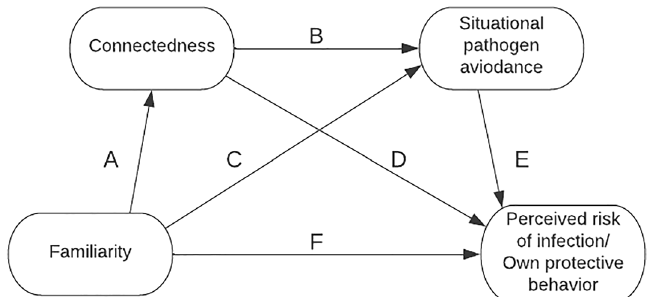
Figure 1. Multiple mediation model predicting perceived risk of infection and protective behaviours. Note: Data from the present studies show that greater familiarity was related to greater connectedness, which was associated with less situational pathogen avoidance. Less situational pathogen avoidance was related to lower perceived risks of infection and fewer protective behaviour. In all analyses the multiple mediation via connectedness and disgust were significant.